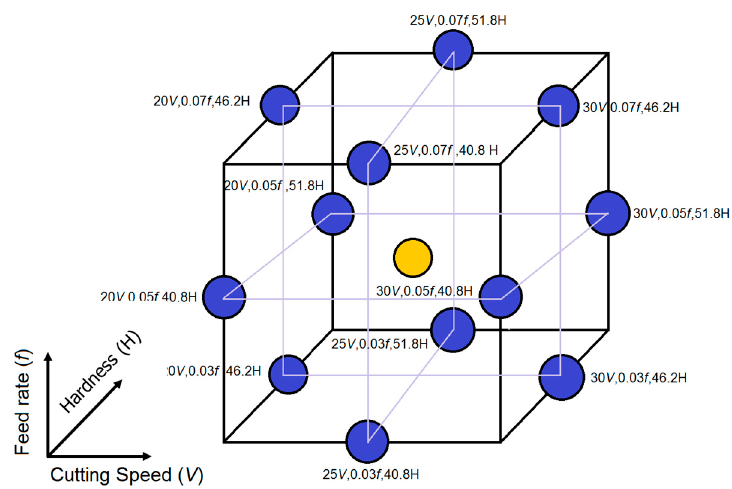
Figure 6. Box-Behnken experiment design.